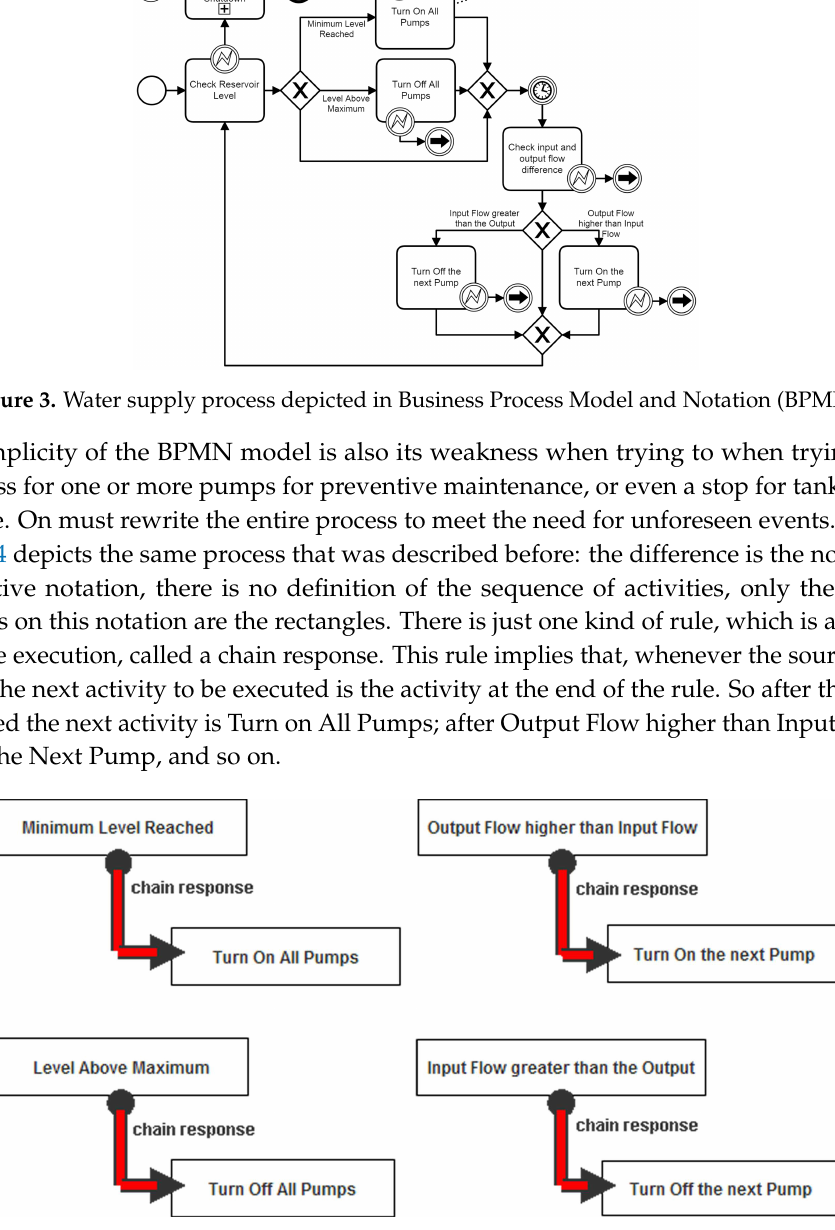
Figure 4. Water supply process depicted in the declarative